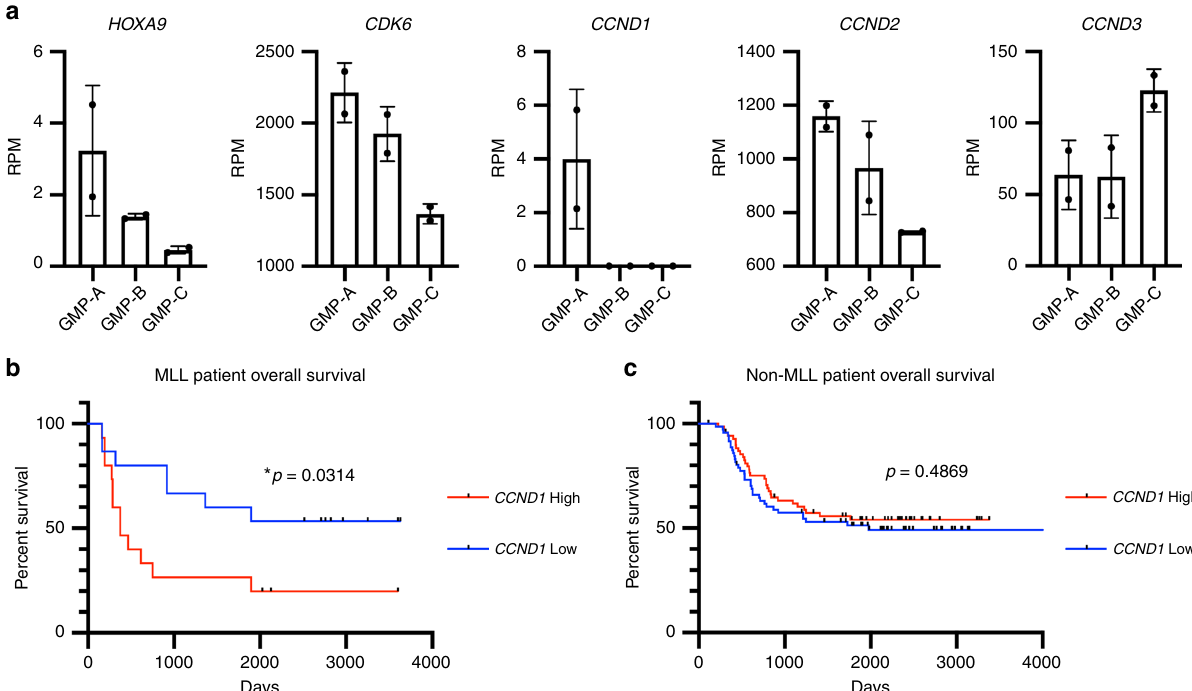
Fig. 9 CCND1 expression level strati fi es MLL translocation leukemia patient survival. a Expression levels of HOXA9 , CDK6 , and CCND1/2/3 in human GMP subsets. RNA-seq data from GSE96811 were plotted 35 . Error bars represent s.d. b Overall survival of MLL leukemia patients. Patient data were downloaded from TARGET-AML datasets, and only patients with available RNA-seq data were included in the analysis. 30 MLL leukemia patients were divided into two groups according to their CCND1 expression level. 15 patients with CCND1 level higher than median were grouped as CCND1 High, 15 patients with CCND1 level lower than median were grouped as CCND1 Low, p = 0.0314, by Log-rank (Mantel – Cox) test. c Overall survivals of nonMLL leukemia patients. Same analysis as described in b was performed in nonMLL leukemia patients; n = 72 for CCND1 High group, n = 71 for CCND1 Low group, p = 0.4869 by Log-rank (Mantel – Cox)